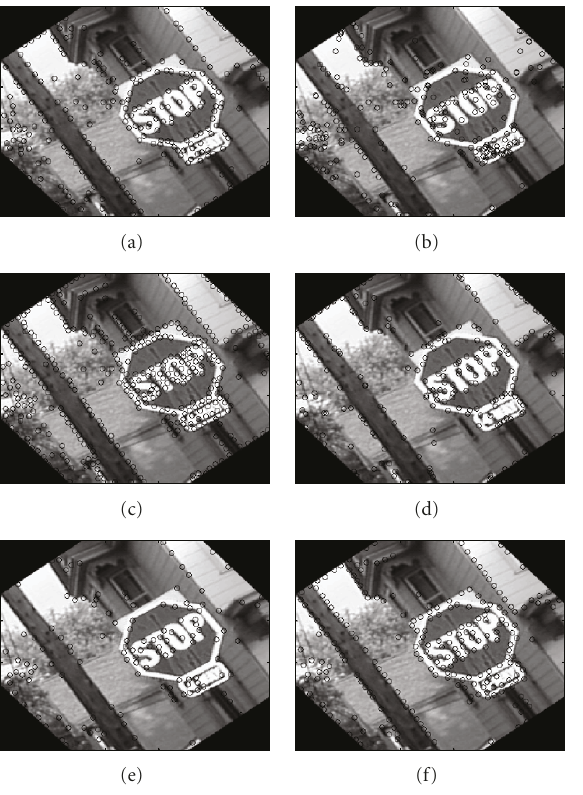
Figure 8: Feature points detected in 110 ◦ rotated image by (a) Harris method (b) Lowe’s method, (c) Tomasi’s method, (d) Loupias’s technique, (e) Yeh’s algorithm, and (f) proposed